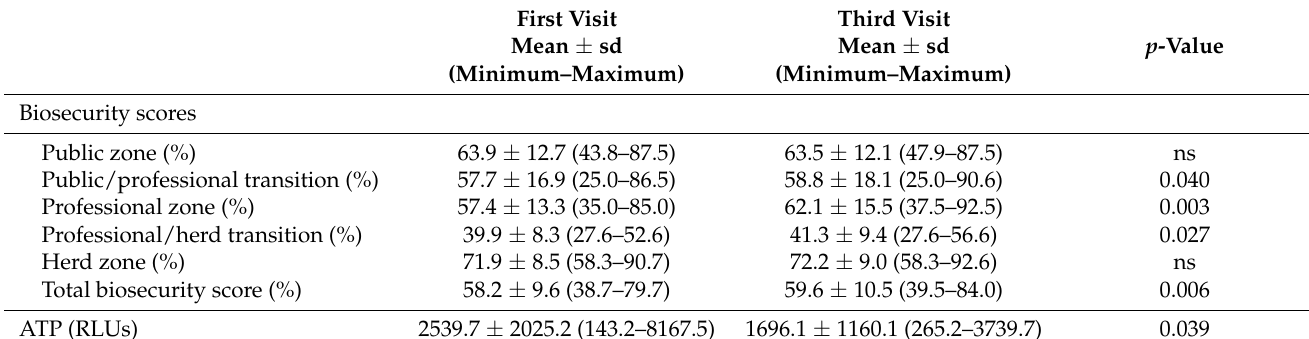
Table 1. Descriptive analysis of the farms ( n = 20) at the beginning and at the end of the study: biosecurity scores for each of the 5 zones and adenosine triphosphate (ATP) values. RLUs = relative light units. Ns = Not statistically